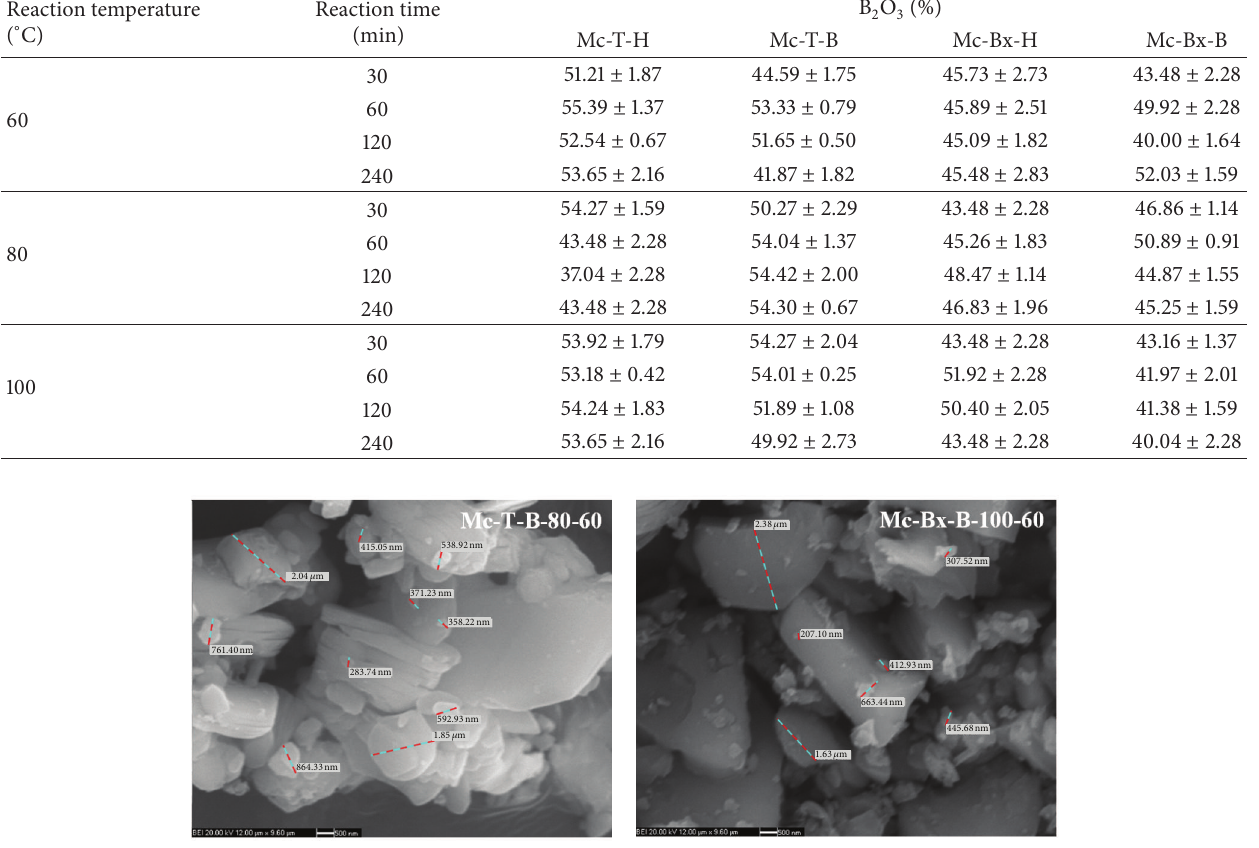
Figure 5: SEM surface morphology and the particle size of admontite minerals.